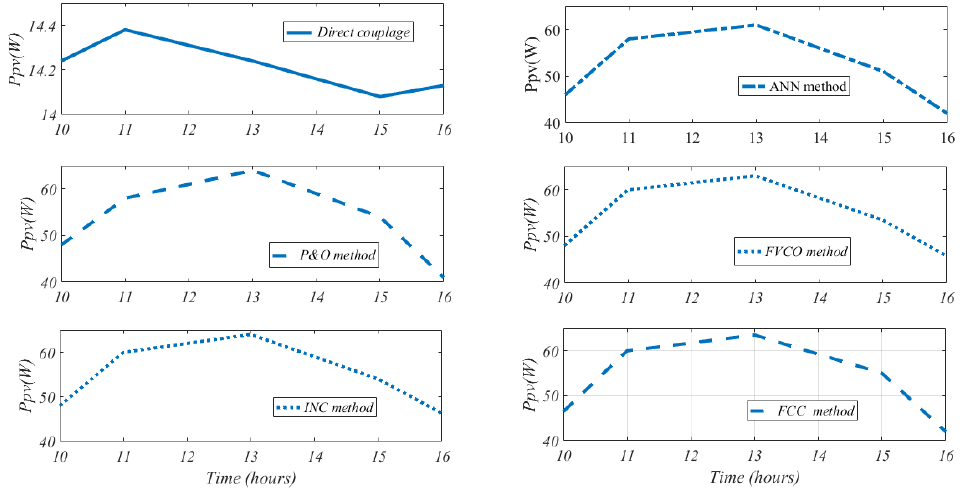
Figure 16. Extracted power by different MPPT algorithms .